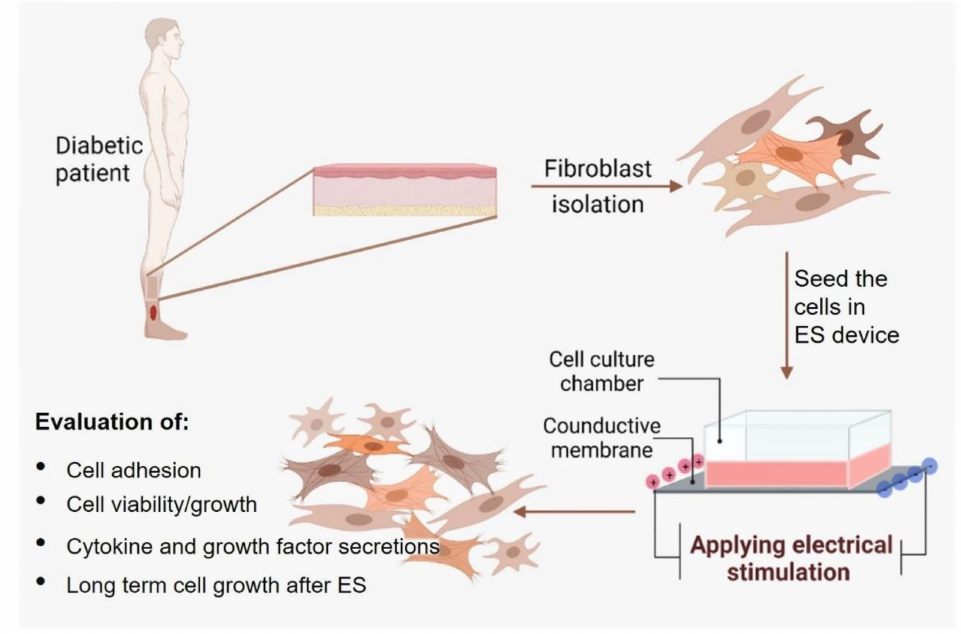
Figure 1. Diagram of the experimental